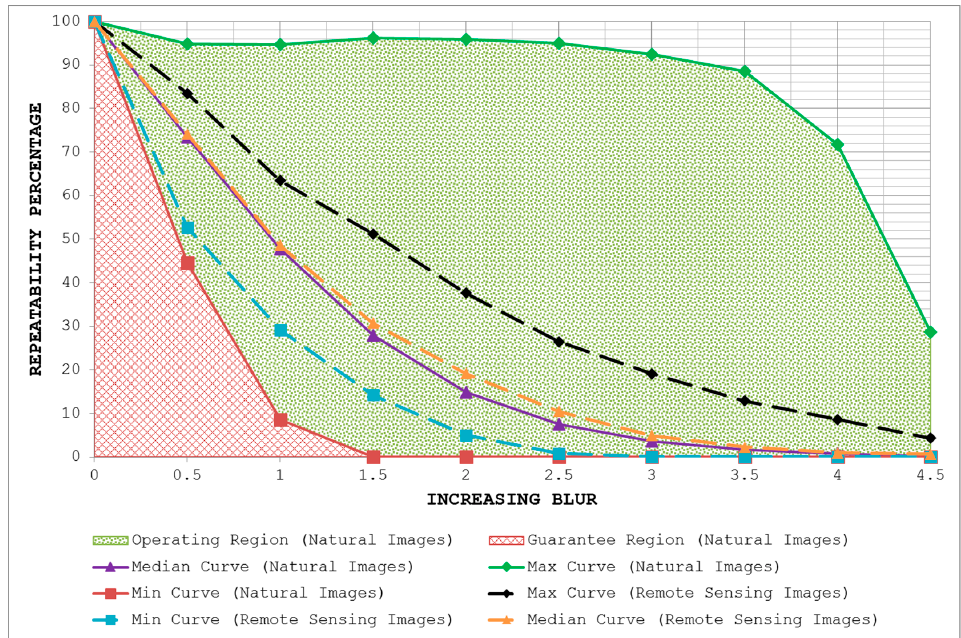
Figure 21. Results of MSER for remote sensing images under increasing blur. The two graphs (natural images and remote sensing images) are overlaid to produce one plot for MSER. Note that although the operating and guarantee regions are defined using the presented database of natural images [50], the curves (median, max and min) in the case of remote sensing images still lie inside the defined operating region and do not cross over to the guarantee region.